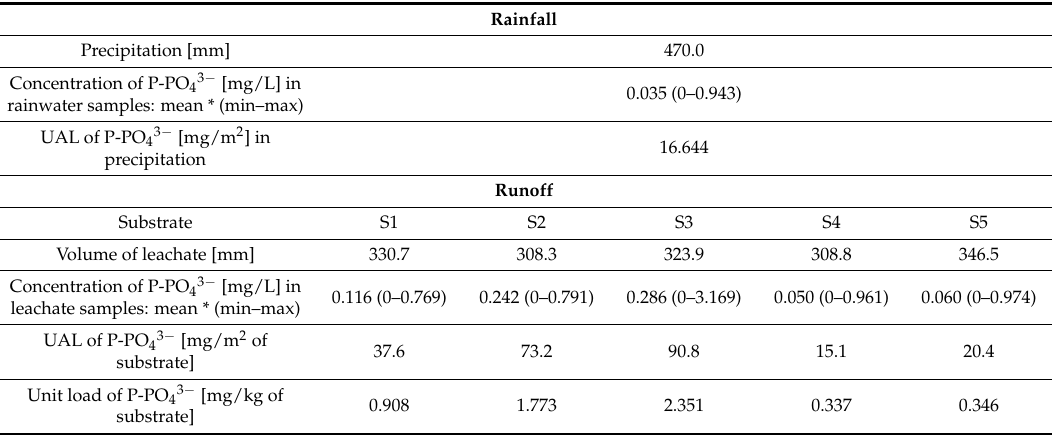
Table 2. Experimental data of column leaching